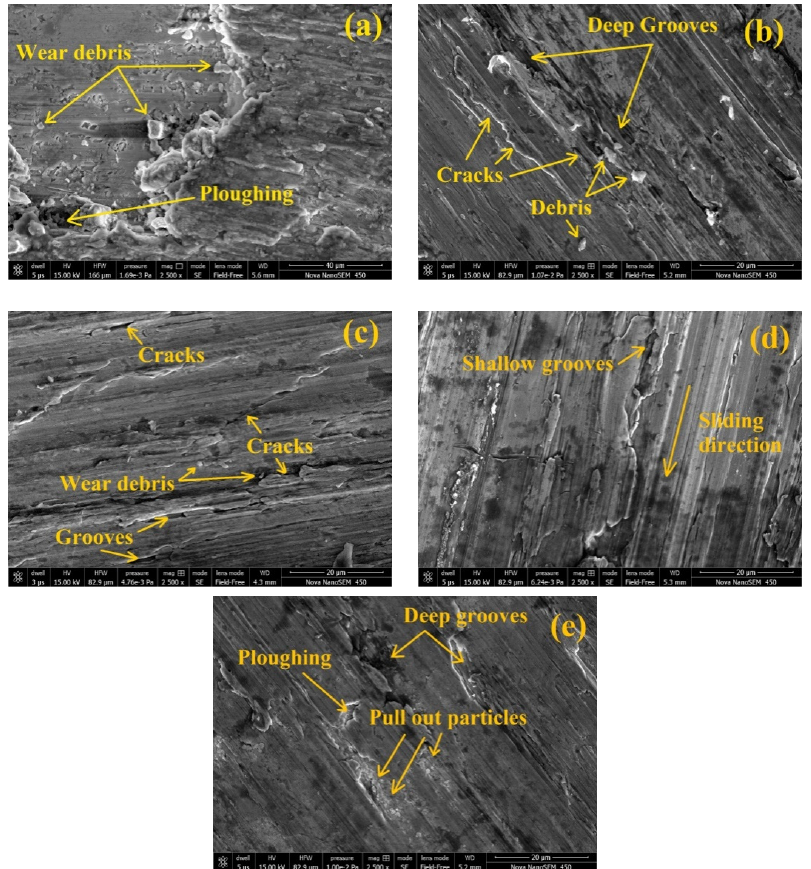
Figure 10. Representative micrographs of selected composite after wear test under 15-N normal load, 4.69 m / s sliding velocity and 1500 m sliding distance of ( a ) A-1, 0 wt.% MD; ( b ) A-2, 1.5 wt.% MD; ( c ) A-3, 3 wt.% MD; ( d ) A-4, 4.5 wt.% MD; ( e ) A-5, 6 wt.% MD reinforced composites.